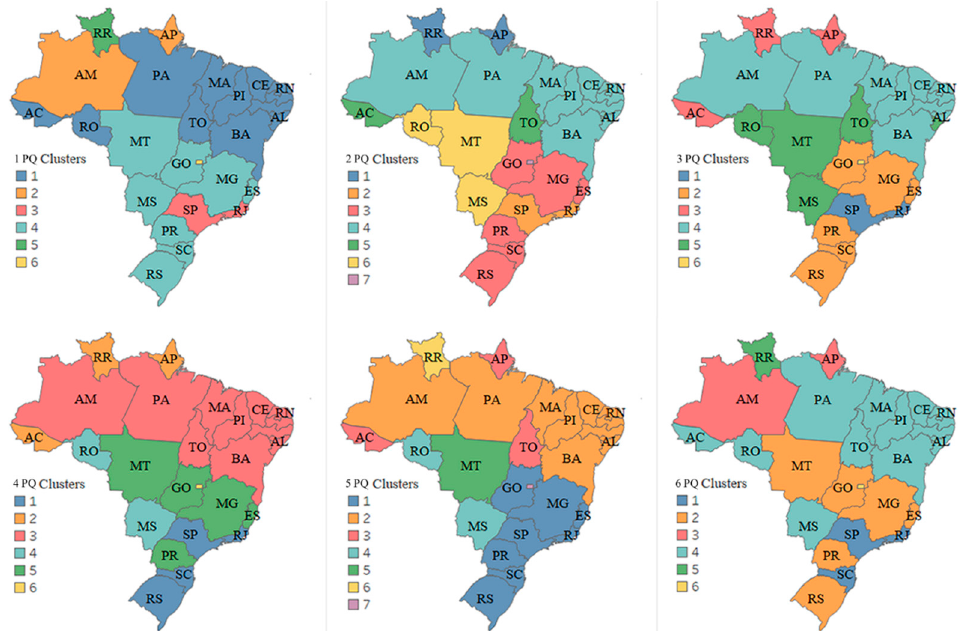
Figure 7. Clustering of Brazil in the pandemic quarters—Infodemic and government cash transfer programs. States assigned to the same cluster share the same color.